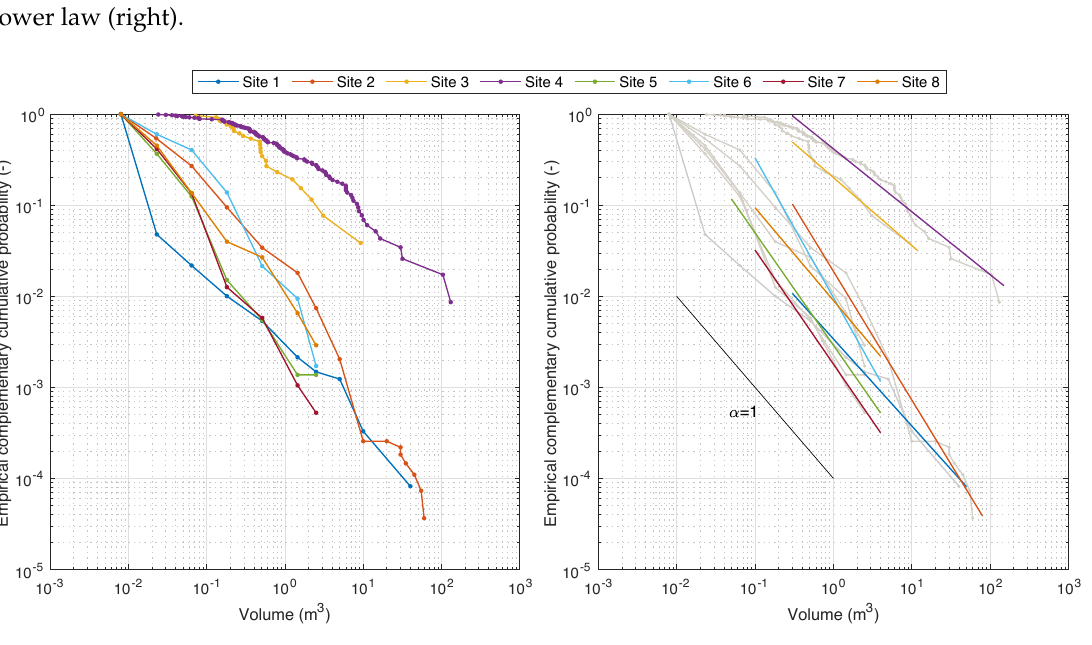
Figure 6. Empirical complementary cumulative distributions of the surveyed block volumes and the best fitting power